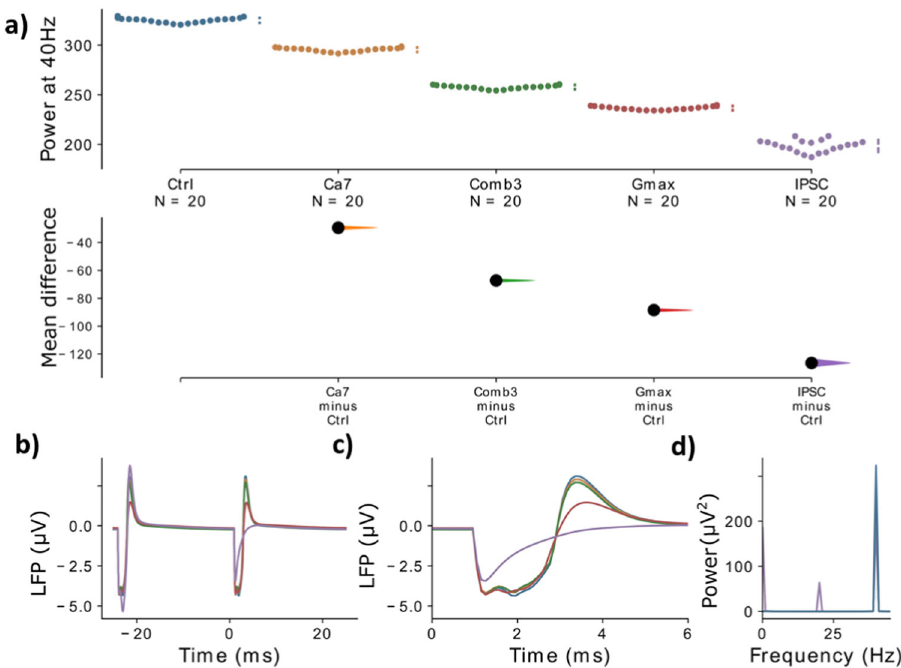
Fig. 5 Comparison of model variants against synaptic alterations. The mean difference for the comparisons of the single model variant and the model variant combination with the strongest gamma reduction together with the two synaptic mechanisms, Gmax and IPSC , against the shared control are shown in the above Cumming estimation plot. The raw data is plotted on the upper axes. On the lower axes, mean differences are plotted as bootstrap sampling distributions. Each mean difference is depicted as a dot. Each 95% con fi dence interval is indicated by the ends of the vertical error bars. b The simulated LFP signal for the control network (blue), Ca7 (yellow), combination 3 (green), Gmax (red) and IPSC (purple) is shown, averaged over two consecutive gamma cycles. c The signals from b are presented with a zoom into the narrow time frame after the stimulus arrives at 0 ms. d The power spectral density (PSD) for the LFP signals from b . Note that in b – d the LFP signal is fi rst averaged over all ‘ subjects ’ and ‘ trials ’ .